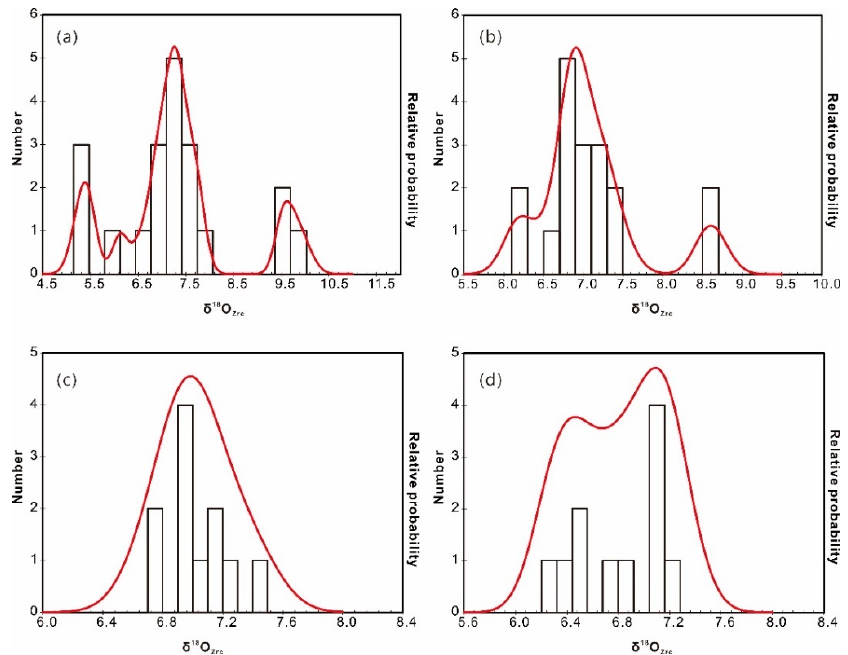
Figure 6. Cumulative probability histograms of δ 18 O Zrc of the zircon cores ( a ) and rims ( b ) from the two-mica granite, and zircon cores ( c ) and rims ( d ) from the biotite granite.